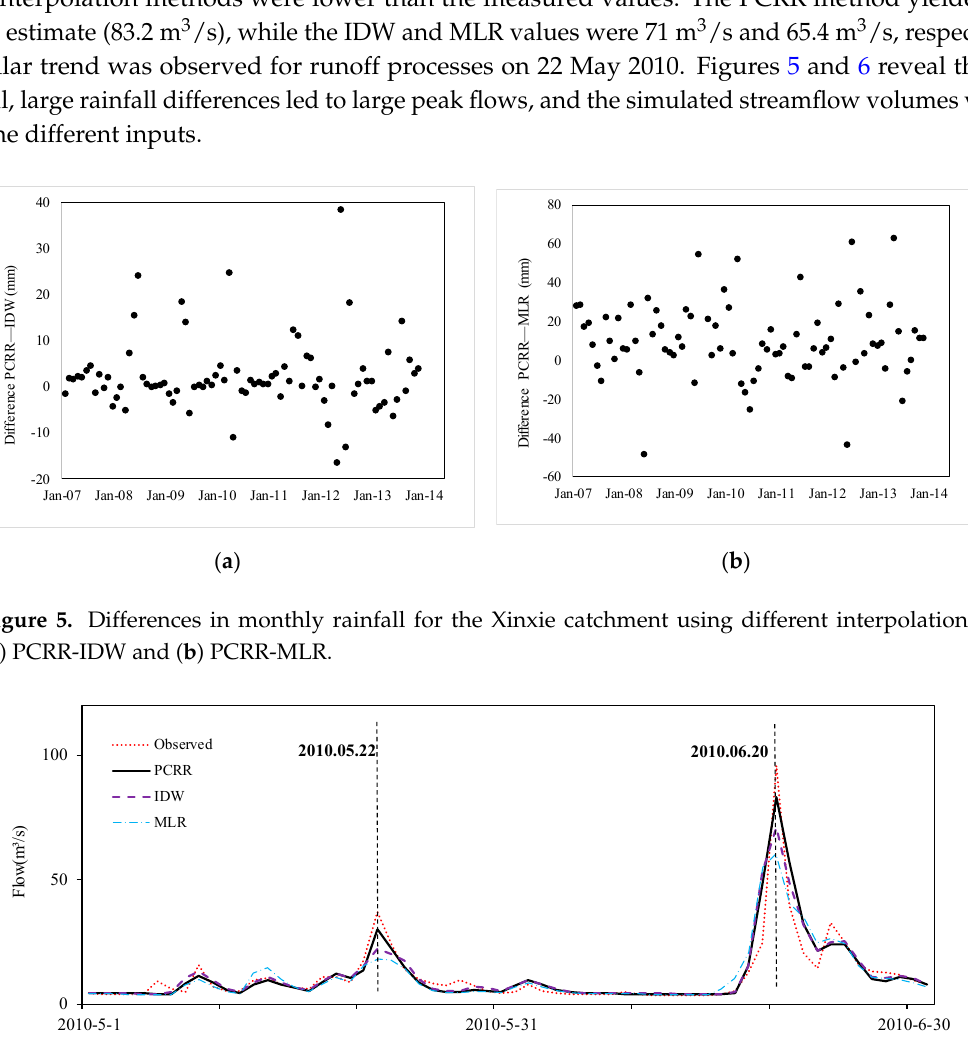
Figure 6. Modeled and measured runoff during May to June 2010 in Xinxie catchment for principal component regression with residual correction (PCRR), inverse distance weighting (IDW), and MLR rainfall interpolation.